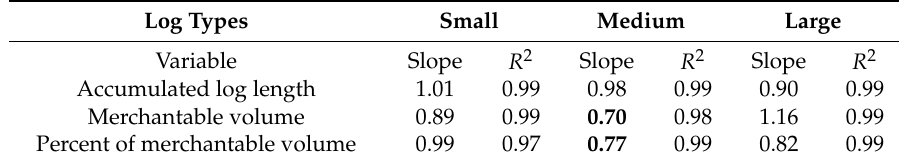
Table 9. Regression analysis for TLS ( x -axis) versus stem analysis ( y -axis) predictions from Model 2. Log